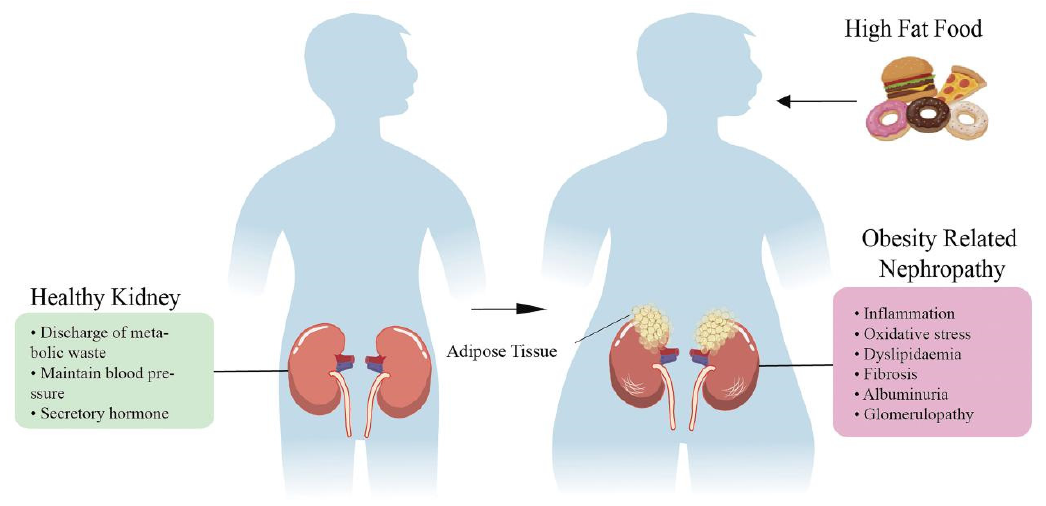
Figure 1. The influence of high-fat food on the progression of renal disease. The kidney has a urinary function. Essentially, dissolved materials in the liquid fraction of blood (plasma) are formed into a filtrate by the action of the kidneys. In this way, the kidneys remove waste and recycle filtered nutrients. In addition, the kidney can affect blood pressure by regulating the urine volume and blood volume or secreting vasoactive substances. The kidney also has the function of producing some hormones with endocrine activity, such as 1,25-dihydroxycholecalciferol [1,25-(OH) 2D3], renin, renal prostaglandin and erythropoietin. The body intake of high-calorie food increases the degree of fat accumulation. When a large amount of fat accumulates in the kidney, it accelerates a series of kidney damage, such as inflammation, oxidative stress and subsequent fibrosis. Long-term fat accumulation further leads to proteinuria, glomerular and tubular diseases.